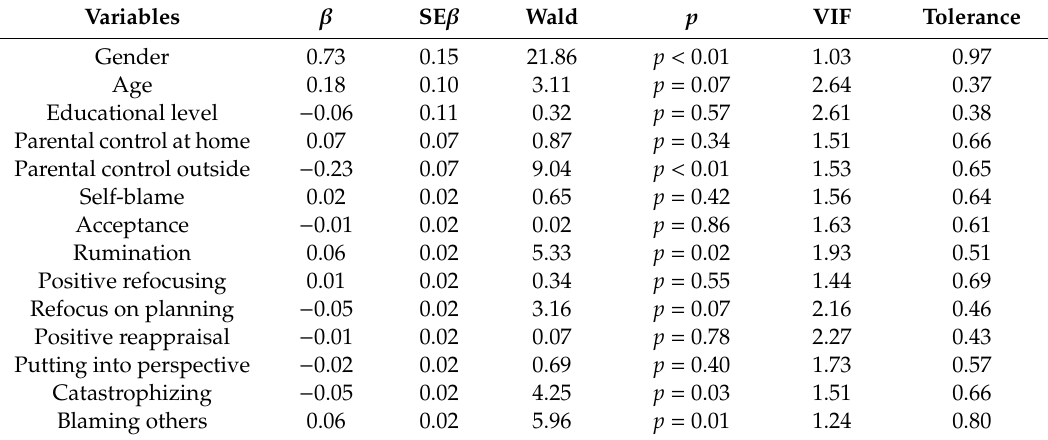
Table 4. Identification of CER strategies to distinguish between problematic and non-problematic smartphone